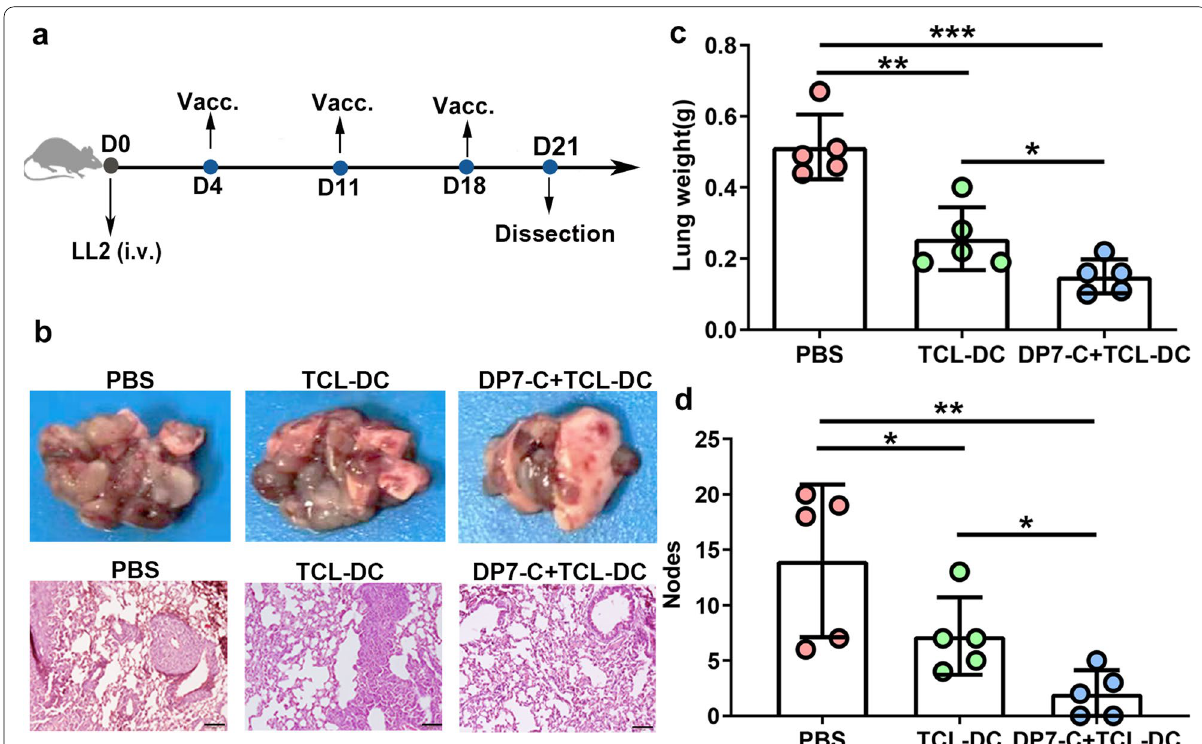
Fig. 1 DP7-C enhances the antitumor effect of DC vaccines loaded with HOCl-oxidized TCL. C57BL/6 J mice ( n with LL2 (3 10 5 ). The DC vaccine was administrated three times with a 1-week interval. a . Diagram of the vaccine workflow. b . Representative × results of metastatic lung nodules and HE staining results of lung tissue in each group. c . Lung weight in each group. d . Number of pulmonary nodules in each group. Scale bars, 50 μm. Significance was calculated using a one-way ANOVA with multiple comparisons tests (* p < 0.05, ** p < 0.01, *** p <